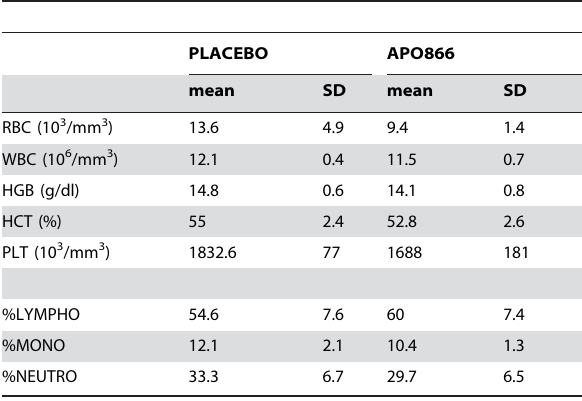
Table 1. Haematological examination of vehicle and APO866- treated mice.